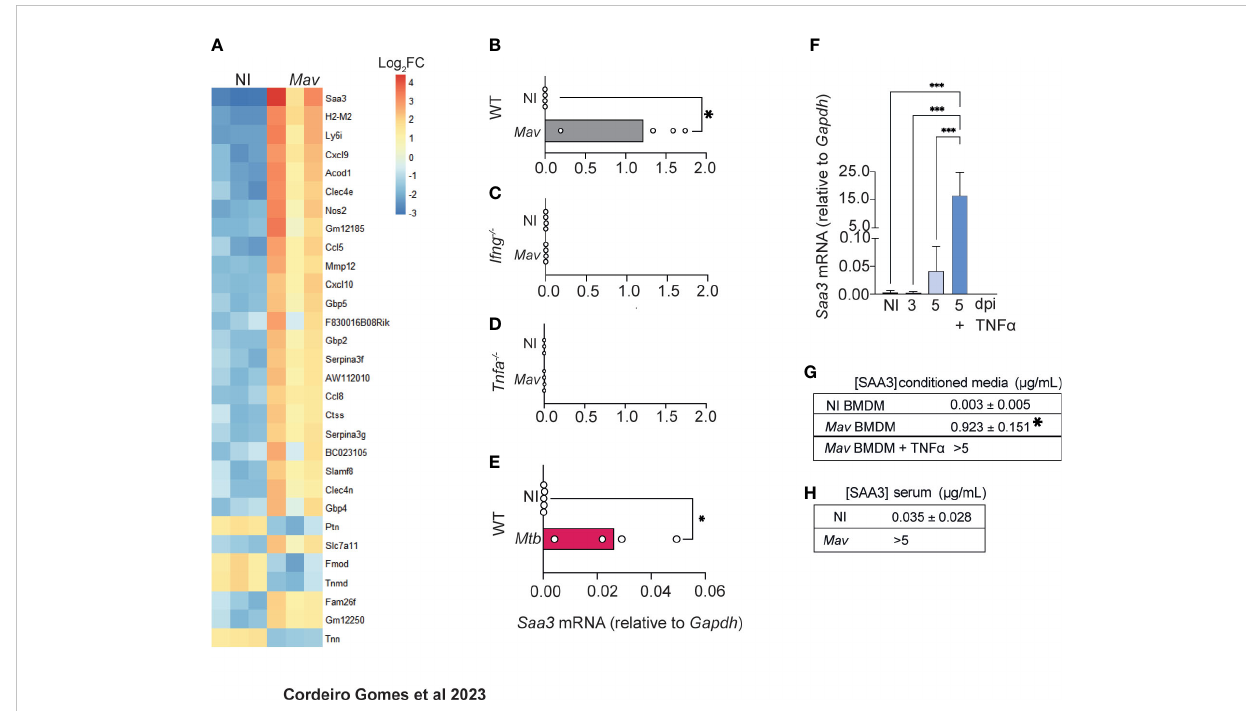
FIGURE 4 M. avium -infected macrophages produce SAA3. (A) Heatmap representing the 30 most differentially expressed genes in the femurs of M. avium - infected mice ( Mav ) compared with non-infected controls (NI). (B – D) Saa3 expression relative to Gapdh in the femurs of non-infected (white bars) and M. avium -infected (gray bars) wild-type (WT, B), Ifng -/- (C) , and Tnfa -/- (D) mice. Bars indicate mean and circles depict individual mice analyzed. (E) Saa3 expression in the bone marrow of mice infected with M. tuberculosis by the aerosol route. Bars indicate the average and circles depict each individual mouse. *, p<0.0,5, by Student ’ s t test. (F) Saa3 expression relative to Gapdh in bone marrow derived macrophages. Bars represent the average ± standard deviation of the 4 replicates in each experimental condition. (G) Quanti fi cation of SAA3 in conditioned media from bone